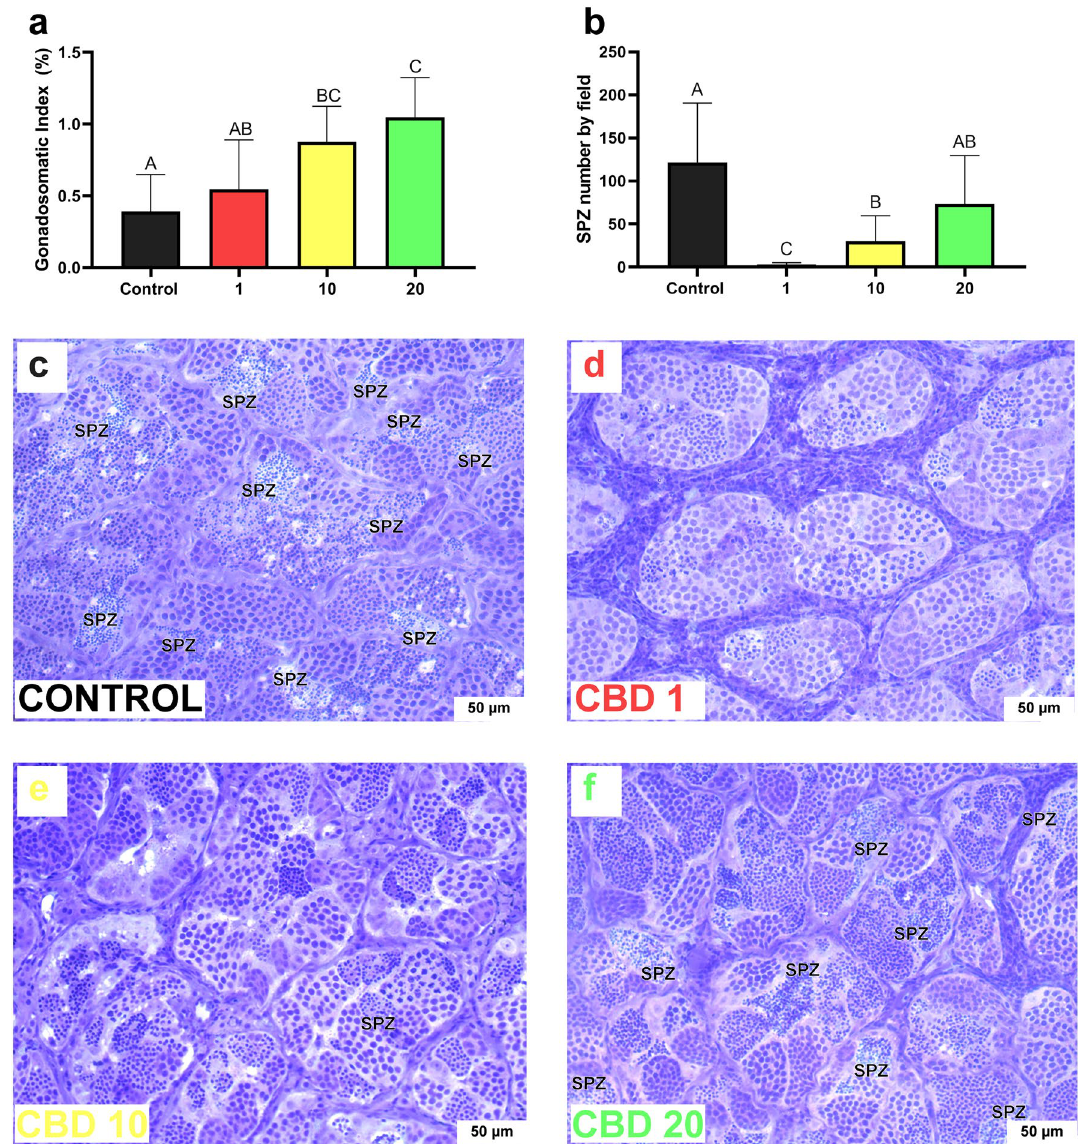
Figure 5. Ex vivo effects of 0 (control), 1 (CBD 1), 10 (CBD 10) and 20 mg/kg (CBD 20) of cannabidiol (CBD) on ( a ) gonadosomatic index (GI) of Nile tilapias (n = 10) and ( b ) the mean spermatozoa (SPZ) number by field (total of 20 fields by fish) in testicular explant from Nile tilapias (n = 5). Fish were exposed for 35 days to the CBD. Different uppercase letters indicate significant differences between treatments (Tukey HSD test, p < 0.05). The number of SPZs was determined by morpho-histological analysis using ImageJ software. Values are mean ± SEM. ( c , d , e , f ) Histological sections of Nile tilapia testis following 35-days of exposure to CBD. Spermatozoa areas are indicated by SPZ in each figure (scale: 50